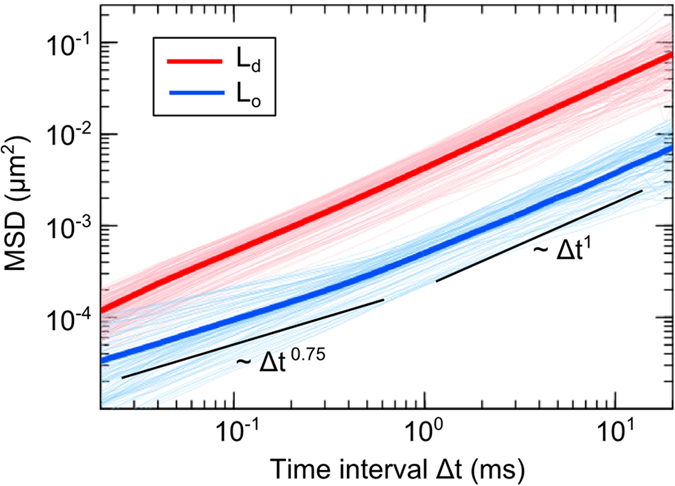
Time-averaged MSD measured in the Ld and Lo domains from 20 μs to 20 ms.166 and 88 trajectories were measured from the Ld and Lo domains respectively, and their MSDs were individually calculated and plotted. The red and blue thick lines are their corresponding ensemble averages. In this double logarithmic plot of MSD, the slope represents the value of anomalous exponent . Two black solid lines show the slopes of 0.75 and one. Single lipid molecules diffuse freely in the Ld domain, as the slopes are nearly one. On the other hand, the lipid molecules undergo anomalous subdiffusion in the Lo domains at the microsecond timescale, indicating the molecular diffusion in the Lo domain experiences nanoscopic heterogeneity within microseconds. The effect of heterogeneity is averaged out at longer timescale and thus apparent Brownian motion is observed at longer time interval (>1 ms).